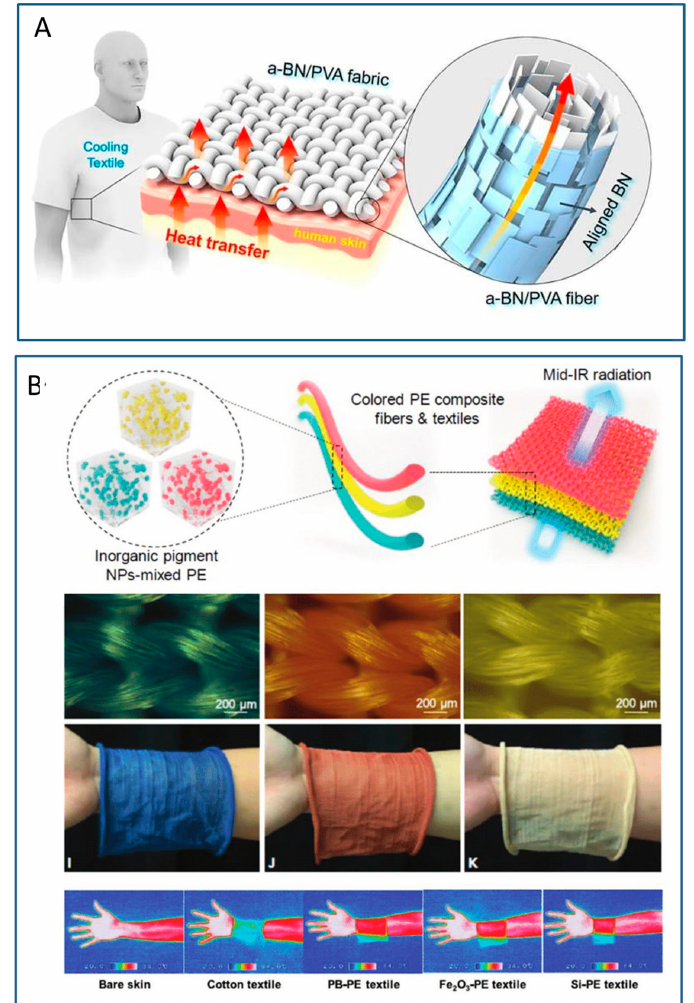
Figure 9. Temperature-controlling fabric textiles. The images are used under permission from [55,56]. ( A ) is a schematic representation of the capability of thermal conductive fabric (highly aligned boron nitride (BN)/poly (vinyl alcohol) (PVA)—named a-BN/PVA fabric by the authors) to improve the thermal transport properties of textiles for personal cooling. ( B ) represents a colored textile used for personal cooling were different colors are obtained according to cooling temperature. Optical micrographs and photos of the knitted colored textile with good wearability for blue PB-PE (I), red Fe 2 O 3 -PE (J), and yellow Si-PE